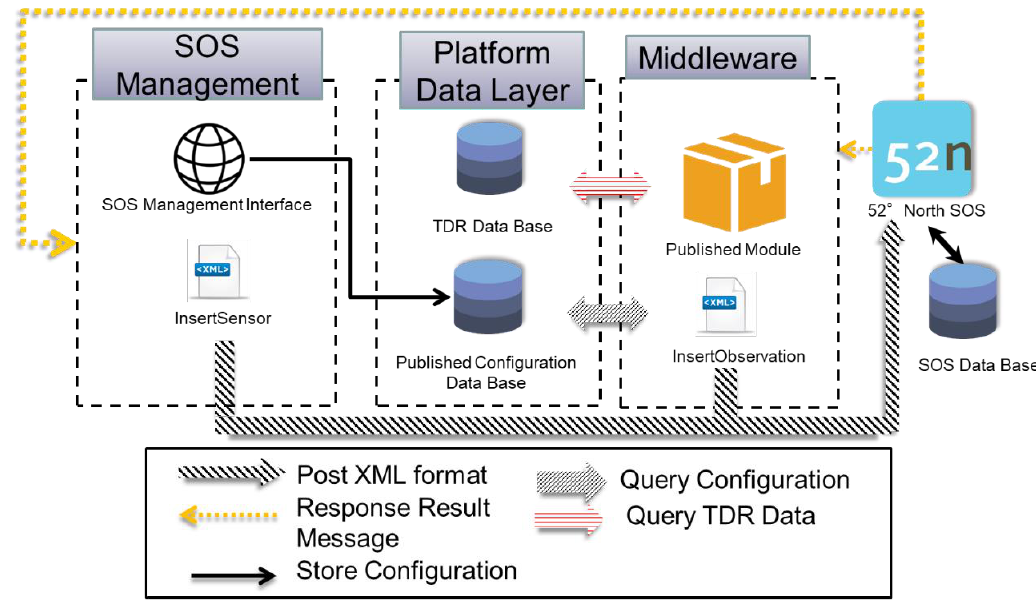
Figure 18. Connection schema between TDR information system and SOS.